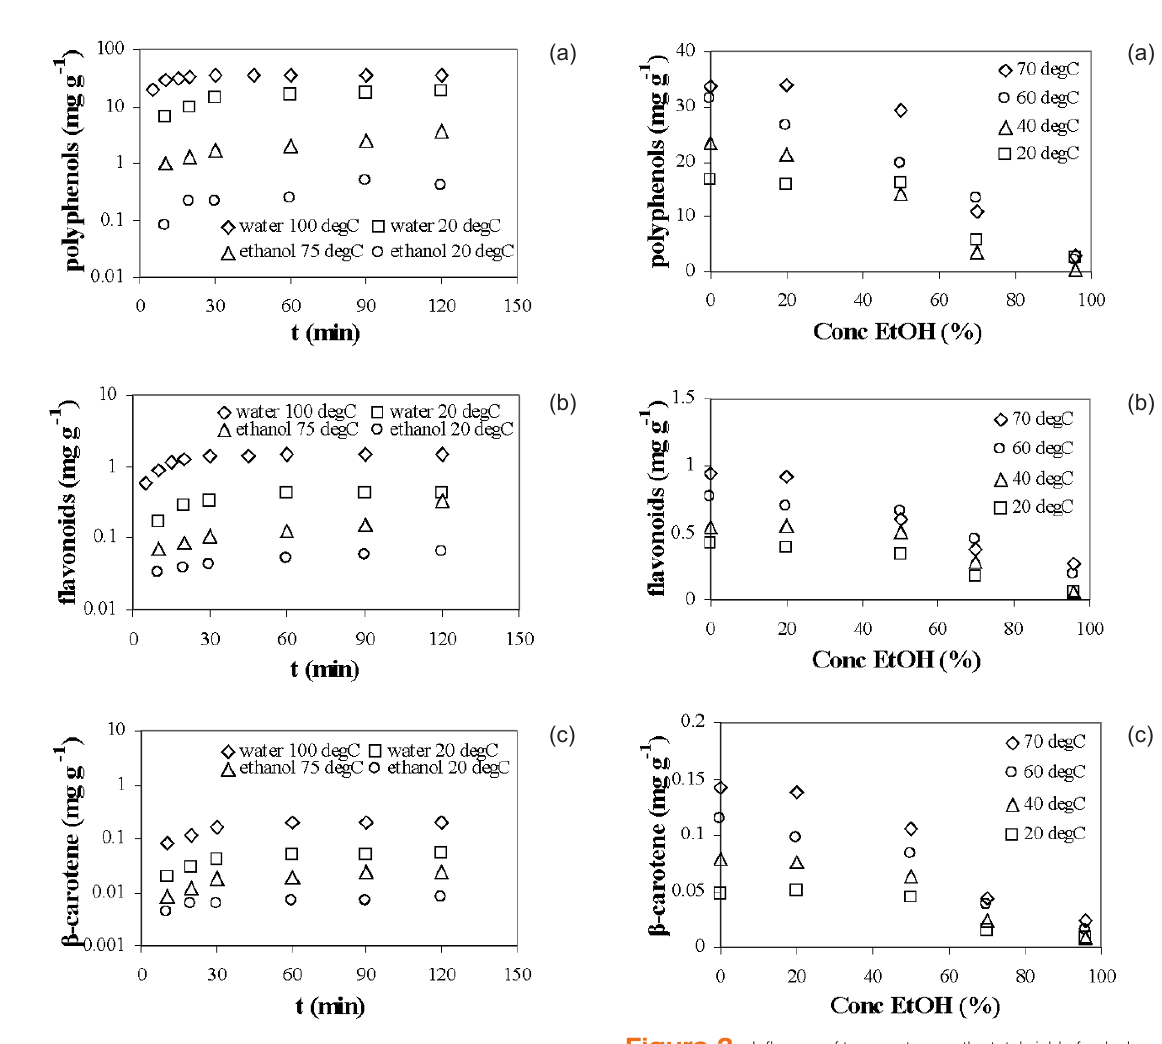
Figure 1. Kinetics of polyphenols (a), flavonoids (b) and β -carotene (c) extraction using water and ethanol as solvents. Figs. 1a-1c present extraction curves as a cumulative yield (mg substance per g raw material) over time for two solvents (water and 96% ethanol) at their boiling points and at ambient temperature.